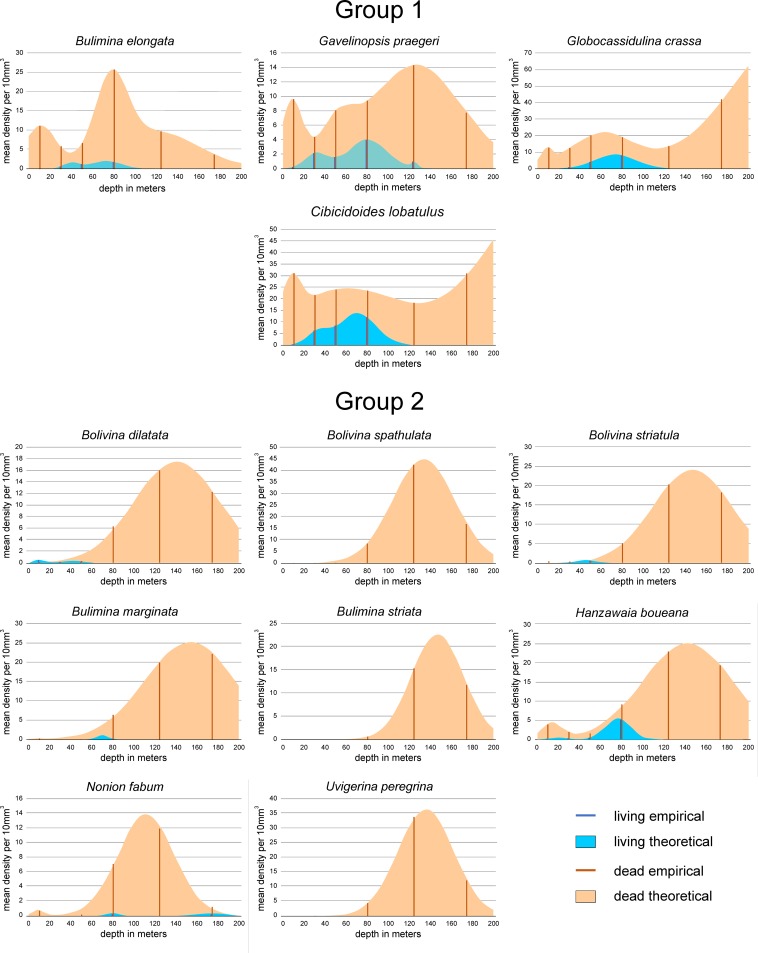
Depth frequencies of living and dead individuals for species of groups 1 and 2 according to UPGMA cluster analysis.Groups are positioned in the CCA of Fig 12.